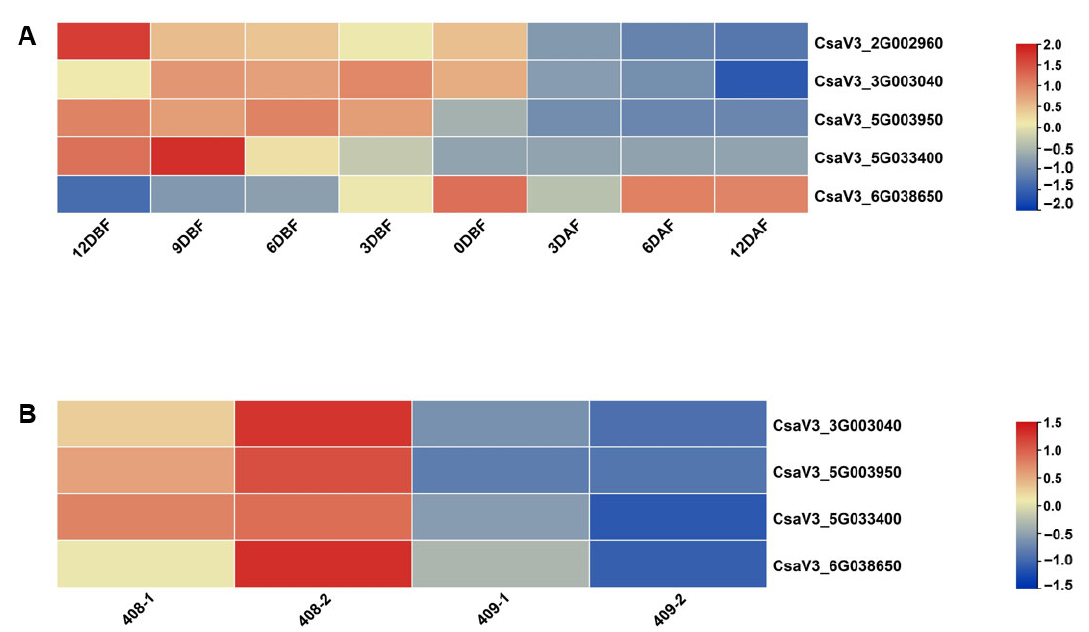
Figure 7. The expression patterns of CsYABBY genes in different development stages of ovary/fruit of cucumber. ( A ) The relative expression levels of CsYABBYs at different development stages of ovary/fruit. ( B ) The TPM values of CsYABBYs at 4 DBF ovary in near-isogenic lines 408 and 409. DBF: days before flowering. DAF: days after flowering. Values are means ± SD of three biological replicates.